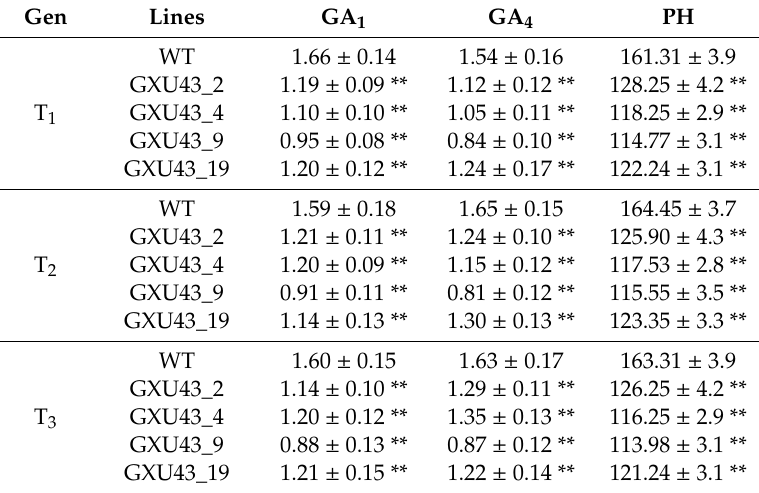
Table 1. Plant height (PH) and gibberellin (GA) content ( µ g / kg FW) in T 1 , T 2 , and T 3 mutant lines. Gen